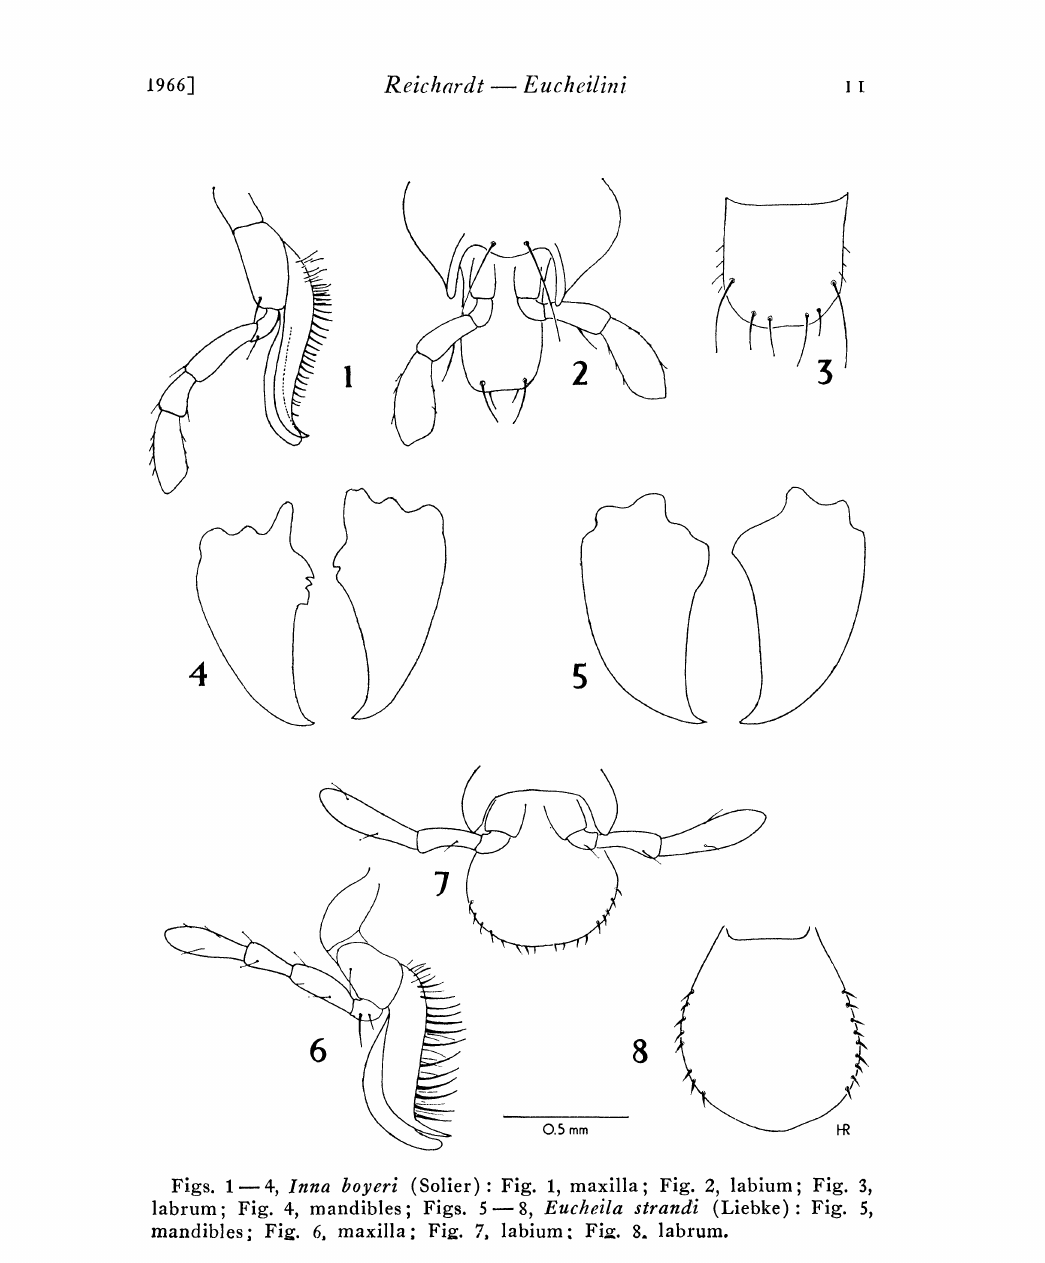
Figs. 1--4, Irma boyeri (Solier)" Fig. 1, maxilla; Fig. 2, labium; Fig. 3, labrum; Fig. 4, mandibles; Figs. 5--8, Eucheila strandi (Liebke) Fig. 5, mandibles; Fi. 6, maxilla; Fi. 7, labium: Fi_. 8.